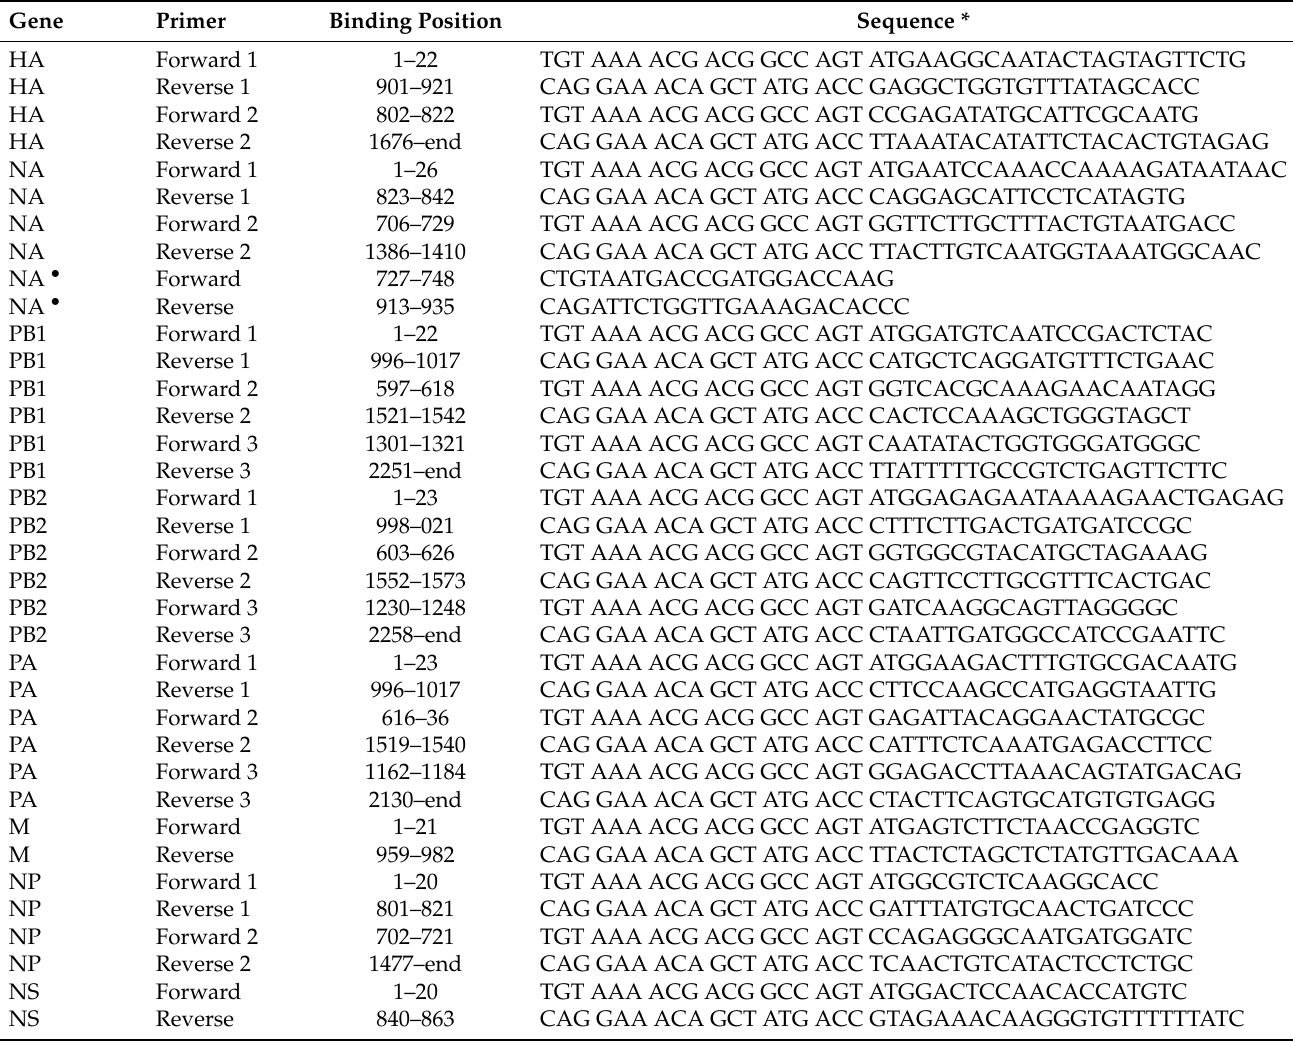
Table 1. Primers used to amplify gene segments of A(H1N1)pdm09